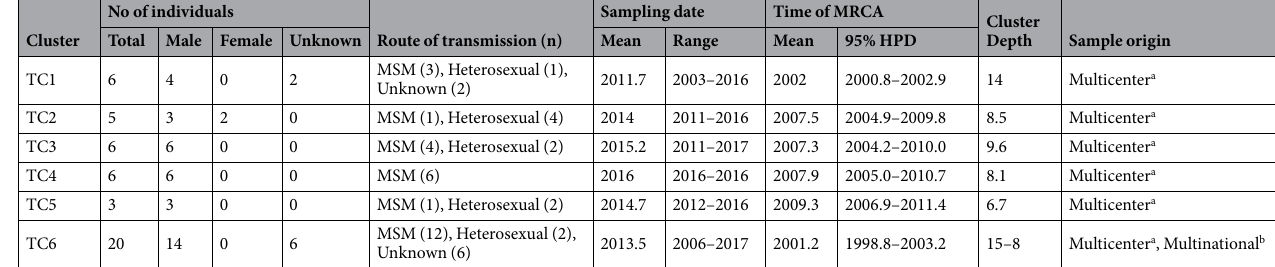
Table 1. Characterization of the six transmission clusters identified in the main A1 cluster. a Samples from more than one of the 14 Portuguese hospital centers. b France, Portugal, Spain, and United Kingdom.